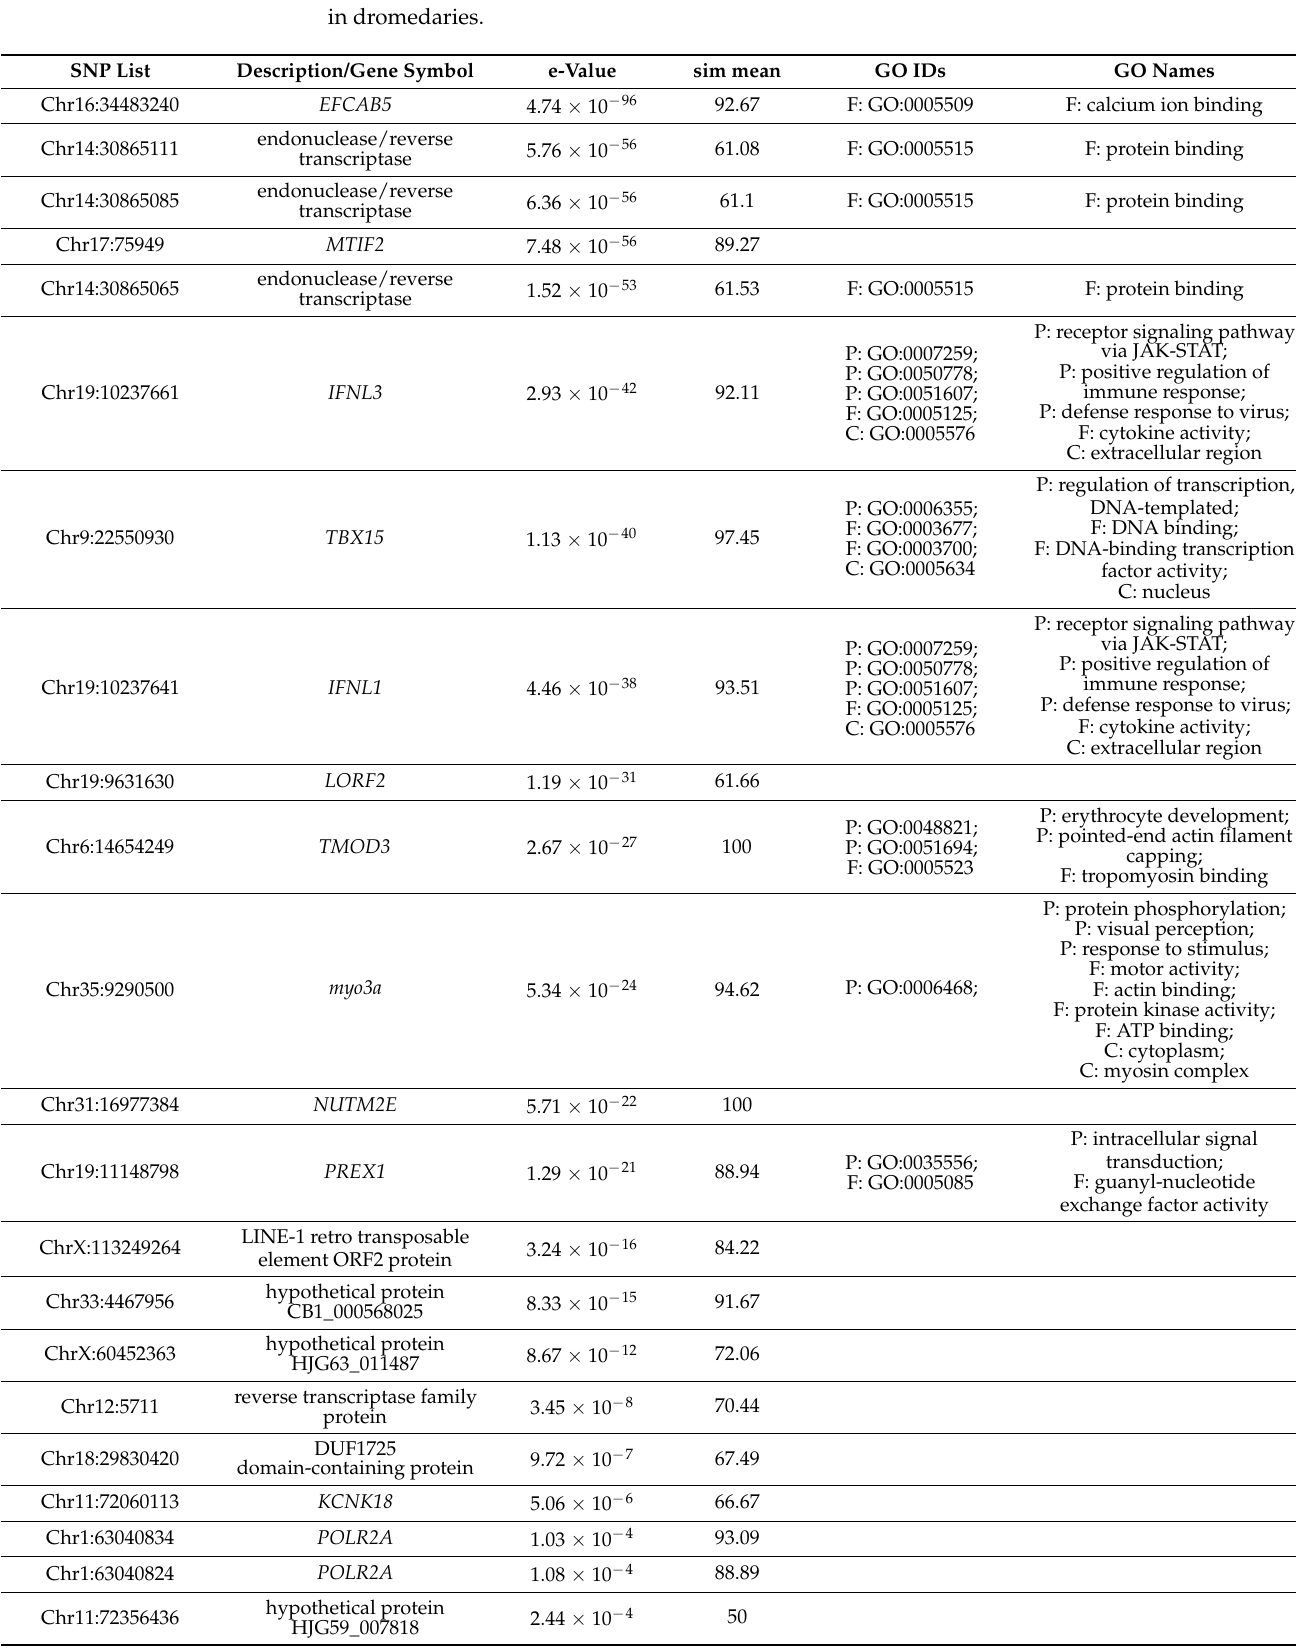
Table 1. Gene set enrichment analysis significantly ( p < 0.001) associated with growth traits in